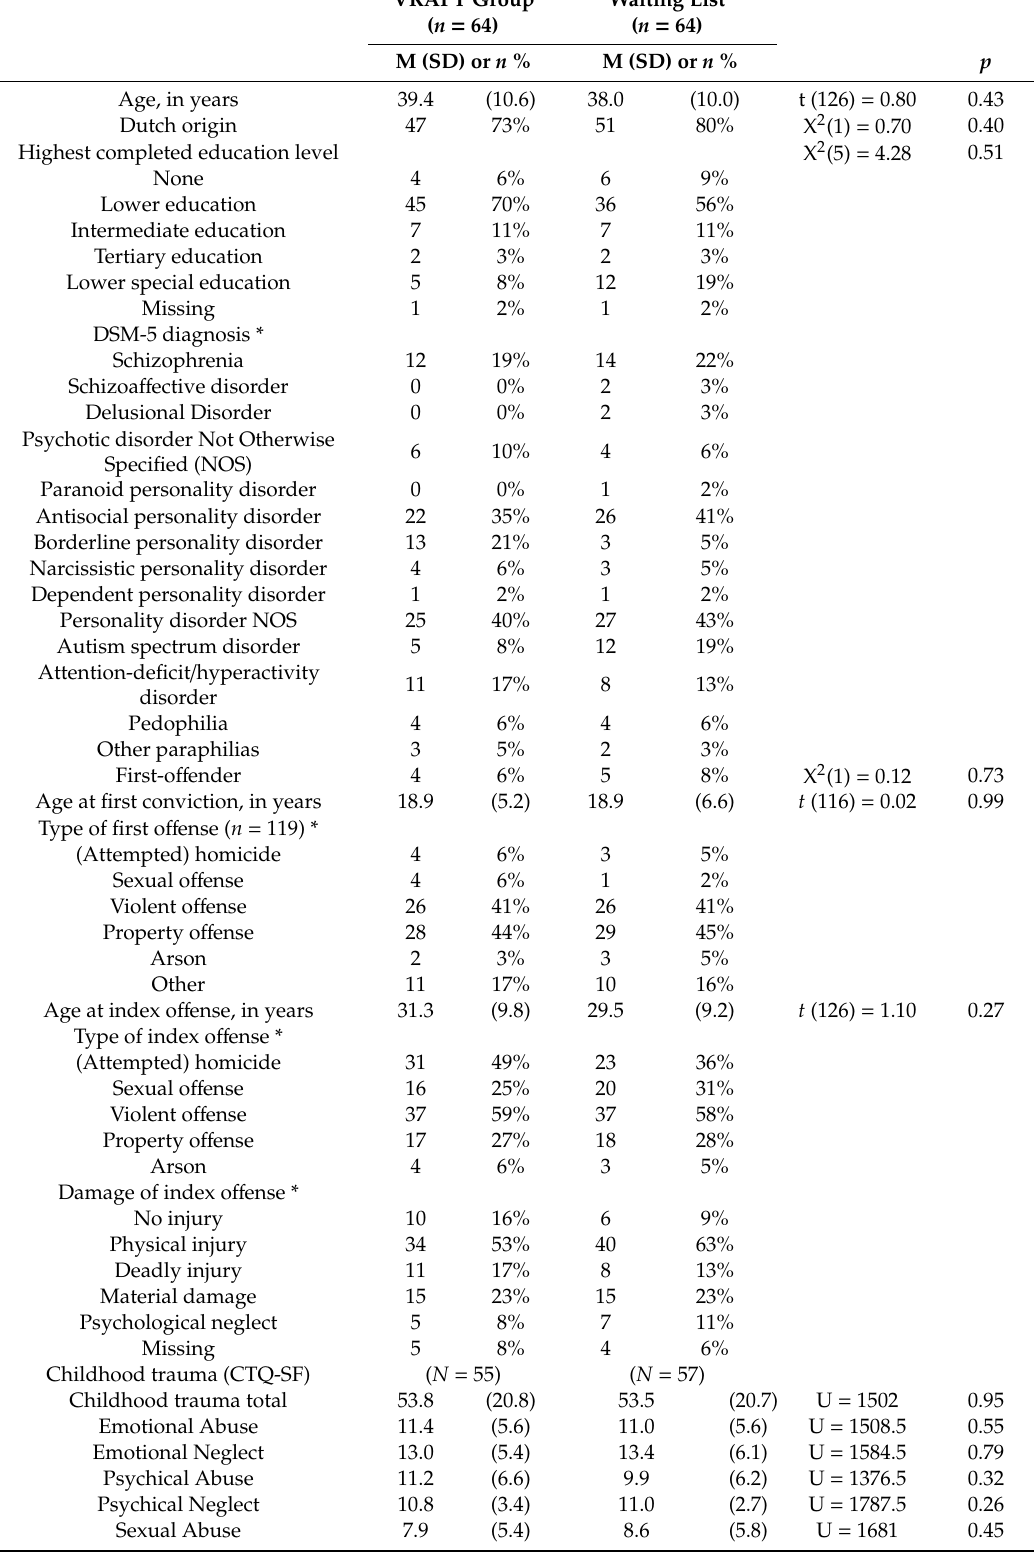
Table 1. Baseline